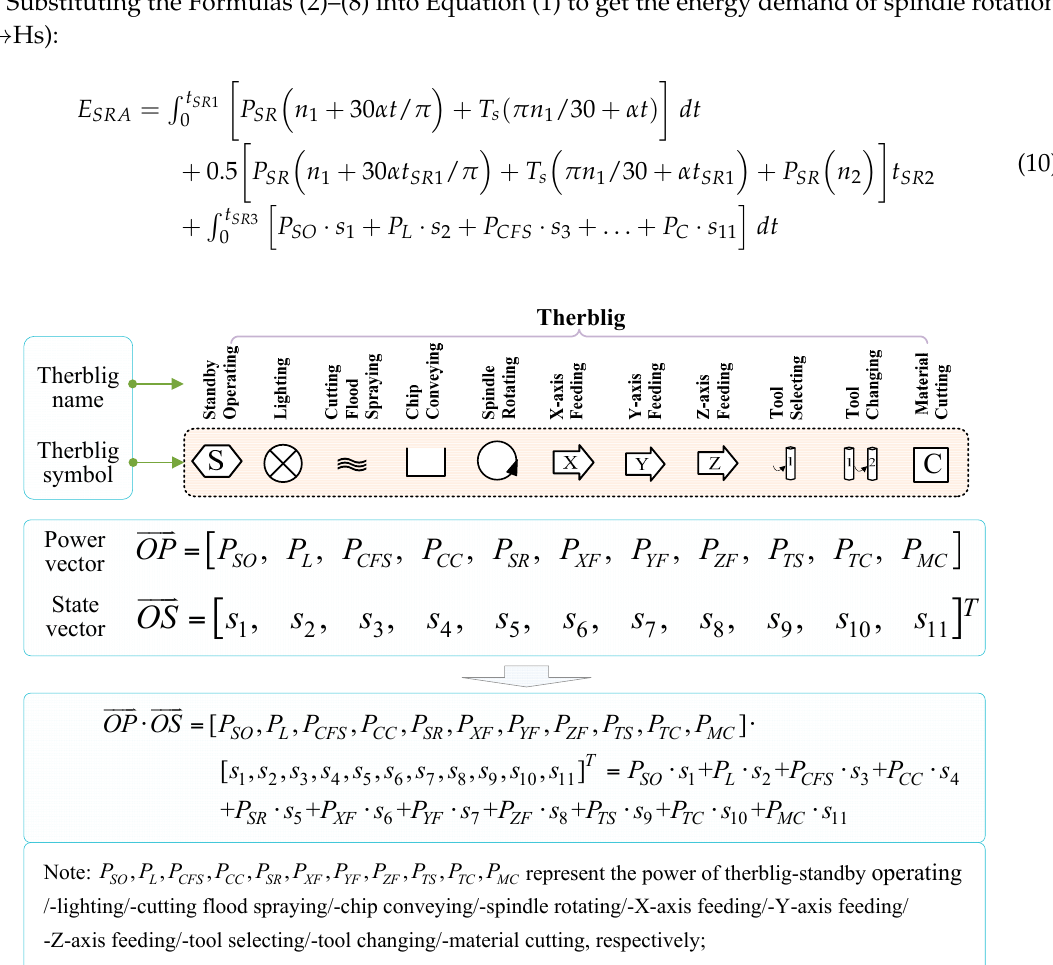
Figure 6. Detail explanations of Equation (7).